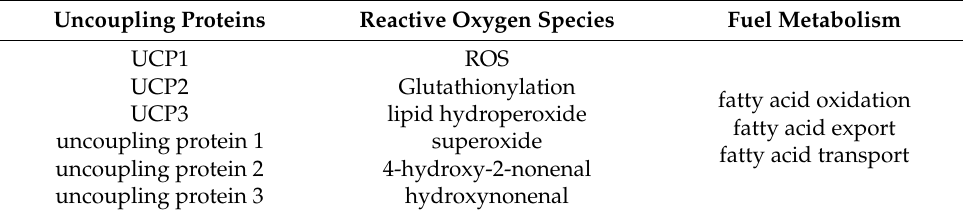
ROS fatty acid oxidation fatty acid export fatty acid